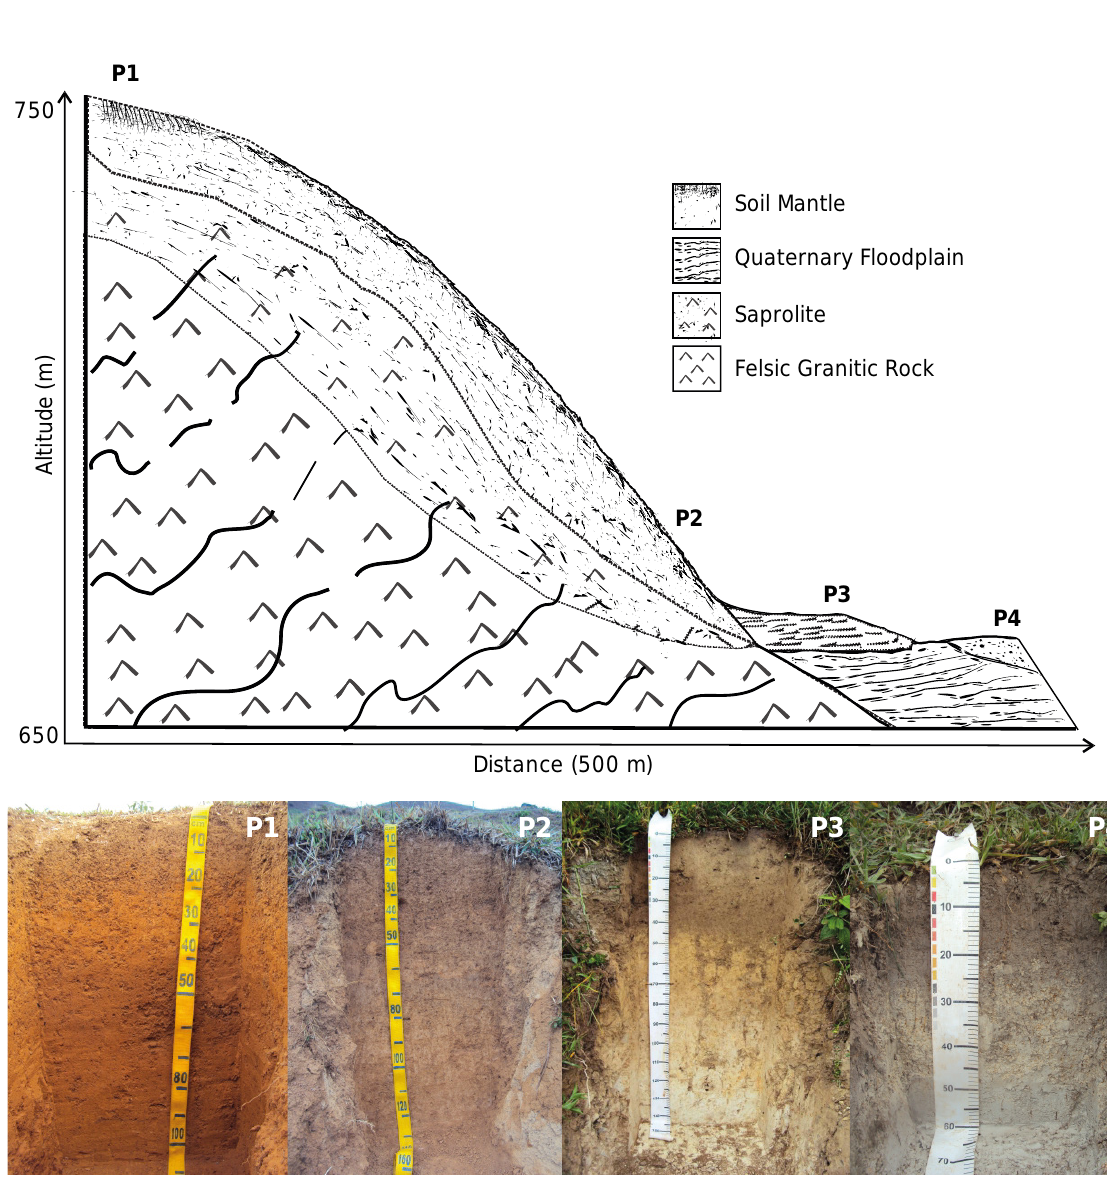
Figure 2. Topographic profile of the topossequence drawn from the digital elevation model and soil profile